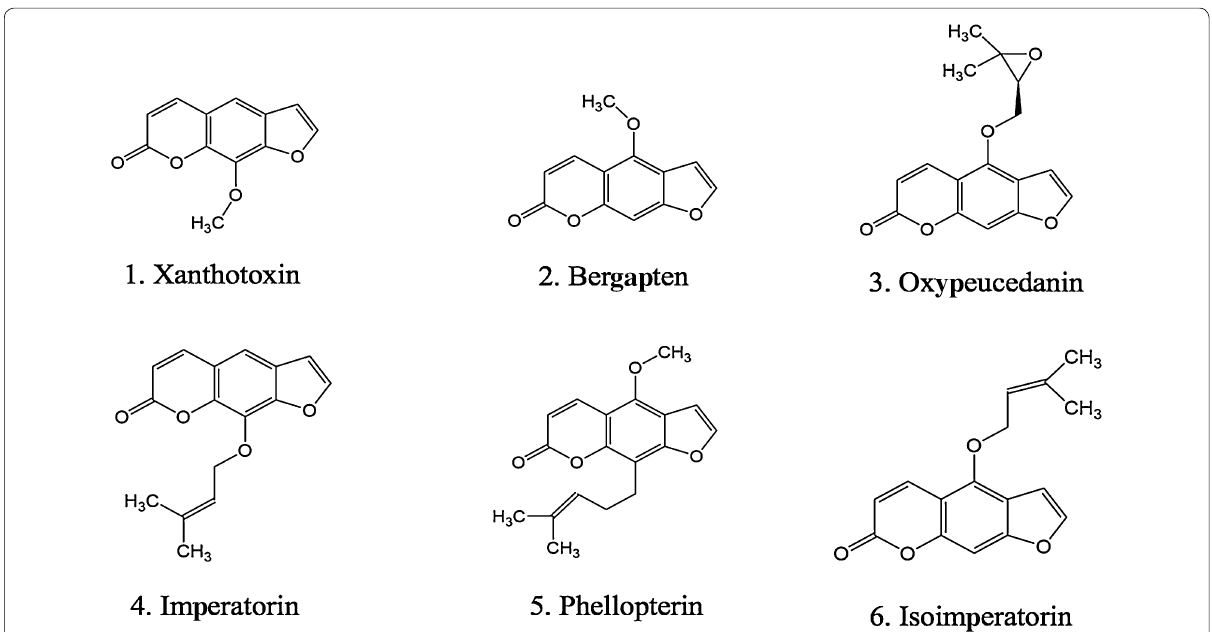
Fig. 4 Chemical structure of furanocoumarins identified from root of